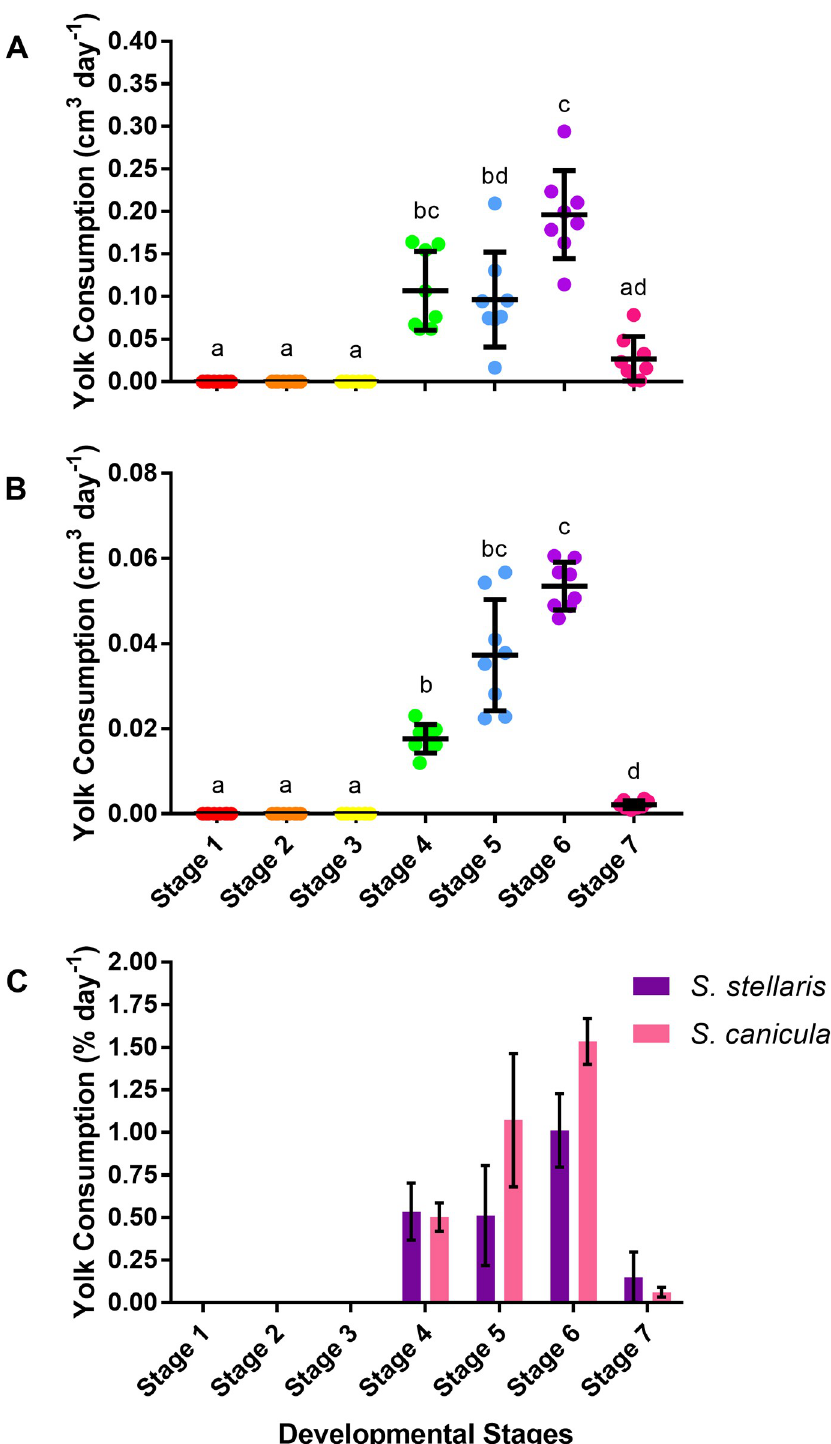
Fig 11. Yolk consumption rate during the 7 developmental stages. A: Yolk consumption rate (cm 3 day -1 ) of S . stellaris embryos during the 7 developmental stages. Lines show mean ± SD (n = 8), while points show measurements from each individual. Dissimilar letters indicate statistical differences between stages (RM one-way ANOVA, P < 0.05). B: Yolk consumption rate (cm 3 day -1 ) of S . canicula embryos during the 7 developmental stages. Lines show mean ± SD (n = 8), while points show measurements from each individual. Dissimilar letters indicate statistical